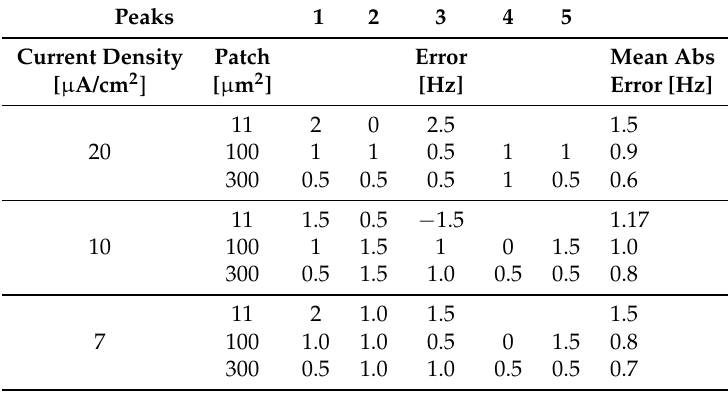
Table 2. Error and mean absolute error between peak frequencies of FFT based PSD and µ 1